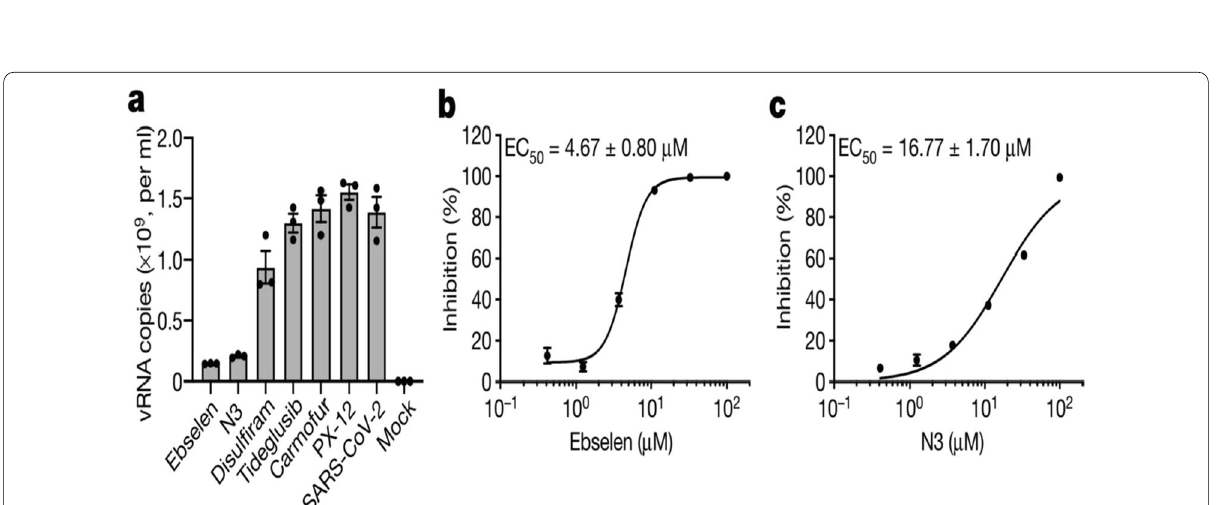
Fig. 5 Images from the ebselen plaque-reduction assay. With respect to the negative control (NC) and the positive control (PC), the number of plaques decreases as the concentration of ebselen increases DMSO. The results are a composite of four biological replicates. The drug’s antimicrobial properties against SARS-CoV-2. a qRT-PCR analysis was used to estimate the number of absolute viral RNA (vRNA) copies (per ml) in the supernatant 72 h after infection. The data represent the mean s.e.m. of three biological replicates, ebselen dose–response curves, and b N3, c plaque-reduction assay. All data are presented as mean s.e.m., based on four biological